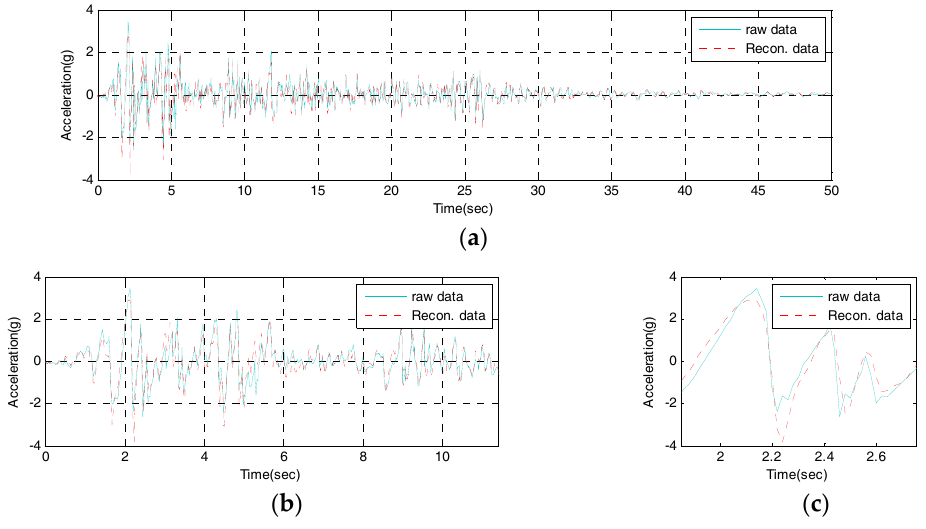
Figure 13. Time domain of the reconstructed signal from the IDAQ system: ( a ) Time from 0 to 50 s; ( b ) Detail 1; ( c ) Detail 2. Sensors 2017 , 17 , 1620